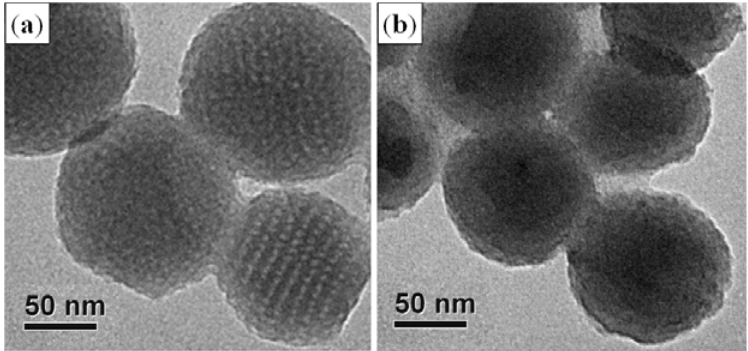
Figure 6. TEM images of OMCS 11 electrodes ( a ) before and ( b ) after assigned charging-discharging processes under various C -rate from 0.1 C to 5 C for 85